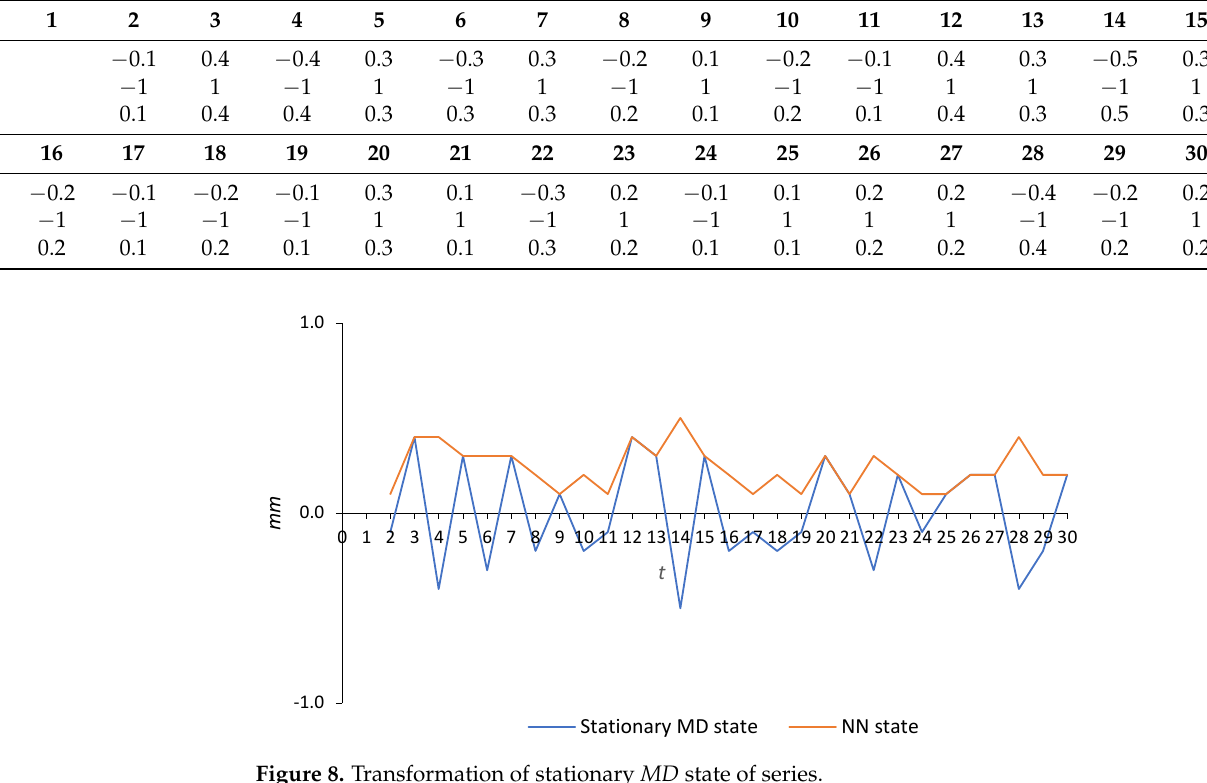
Figure 7. Stationary series.